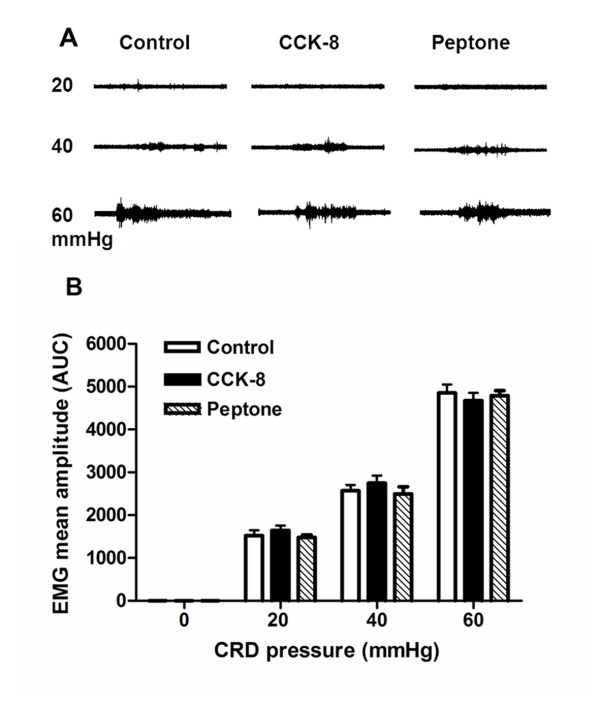
VMR to graded pressure CRDs in control rats, CCK-8 infusion and 5% peptone infusion rats. (A) Representative abdominal muscle electromyograms of the VMR to graded-pressure CRD (20, 40 and 60 mmHg) recorded from the external oblique pelvic muscle in normal rats and rats with CCK-8 and peptone infusion. No obvious difference was found among the three groups. (B) Histograph showed the effects of CCK infusion and 5% peptone infusion on the VMR to graded-pressure CRD in rats. Mean amplitude of the abdominal muscle contraction expressed as AUC after baseline subtraction was presented. No significant difference was found among the three groups. Results were expressed as means ± SE. Statistical comparisons of the VMR in various groups were made by two-way repeated-measures ANOVA, followed by multiple comparisons adjusted by the Bonferroni test, n=5 for each groups.